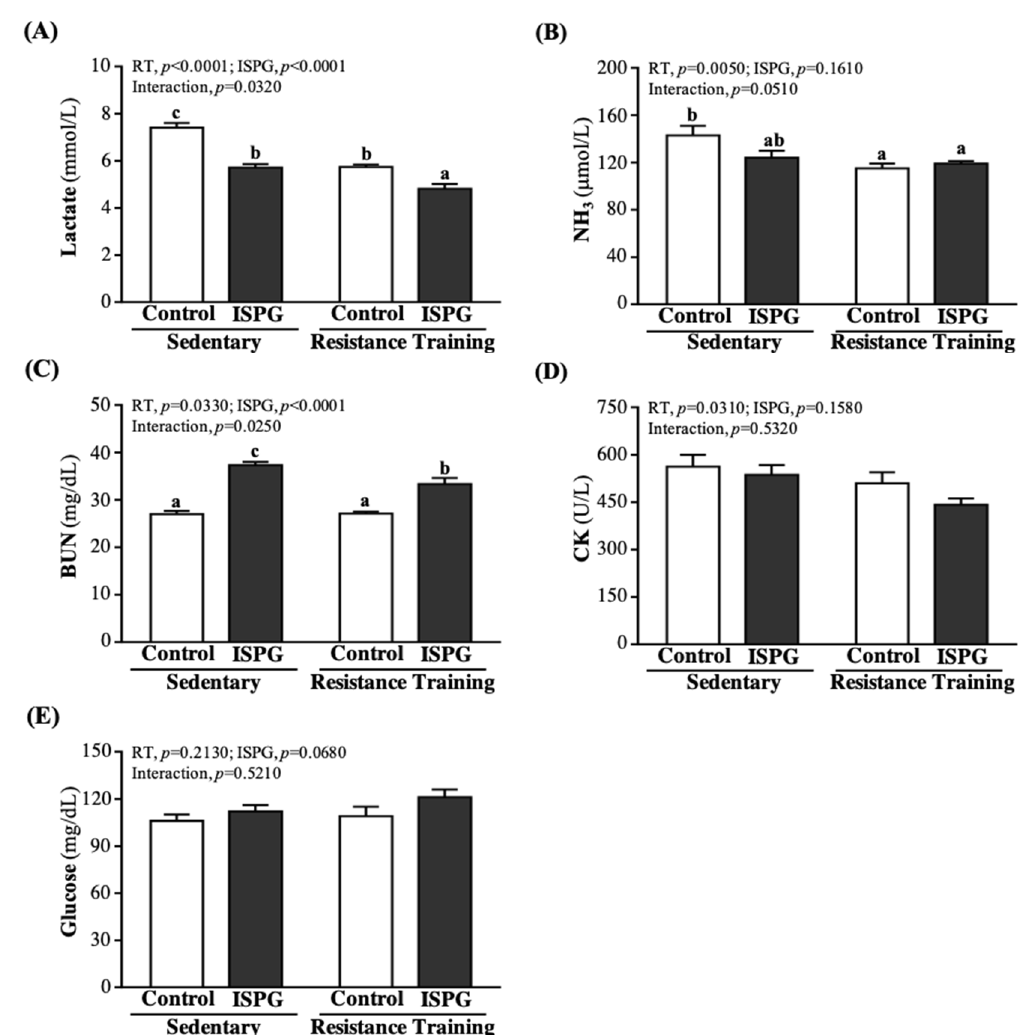
Figure 6. Effect of ISPG and resistance training on fatigue-related biochemical assessments of serum after 15-min acute exercise. ( A ) Lactate, ( B ) NH 3 , ( C ) BUN, ( D ) CK and ( E ) glucose. Data are expressed as the mean ± SEM of 8 mice/group. Different superscript letters (a, b, c) above the bar are significantly different at p < 0.05. If any letter is the same, it means that the difference between groups is not